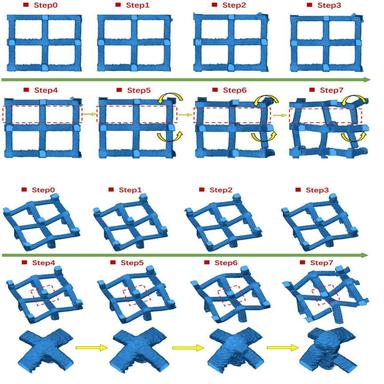
Subvolumes of each 3D reconstruction model, red dashed rectangles manifest the evolution of the deformation of the struts, the yellow arrows indicate the rotation of the node.